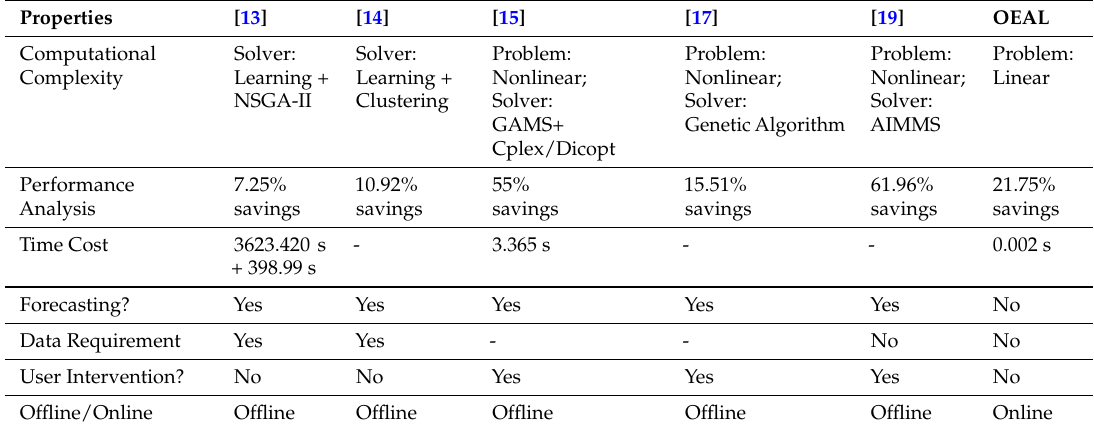
Table 6. Comparison with several related